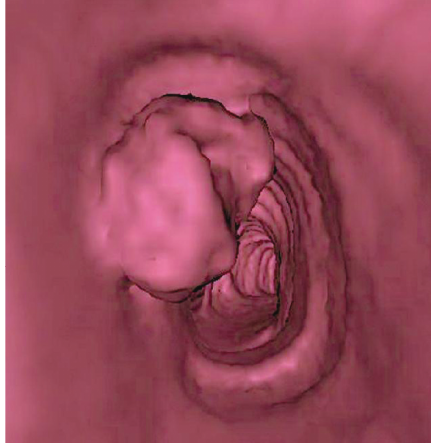
Figure 3: CT scan. Virtual endoscopy demonstrates an endolumi- nal view of the tracheal tumor.